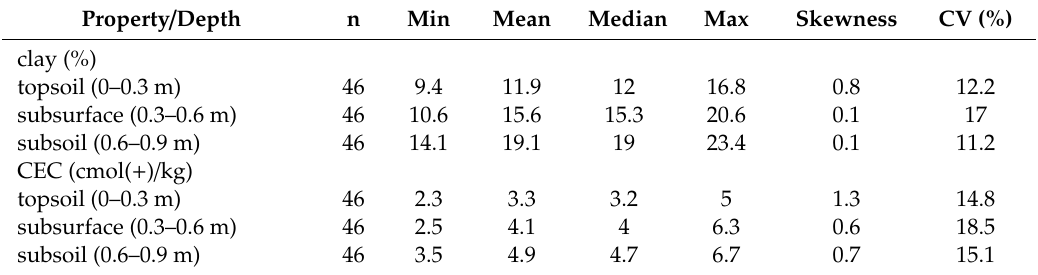
Table 4. Summary statistics of measured clay (%) and CEC (cmol( + ) / kg) at the 46 calibration locations. Property / Depth n Min